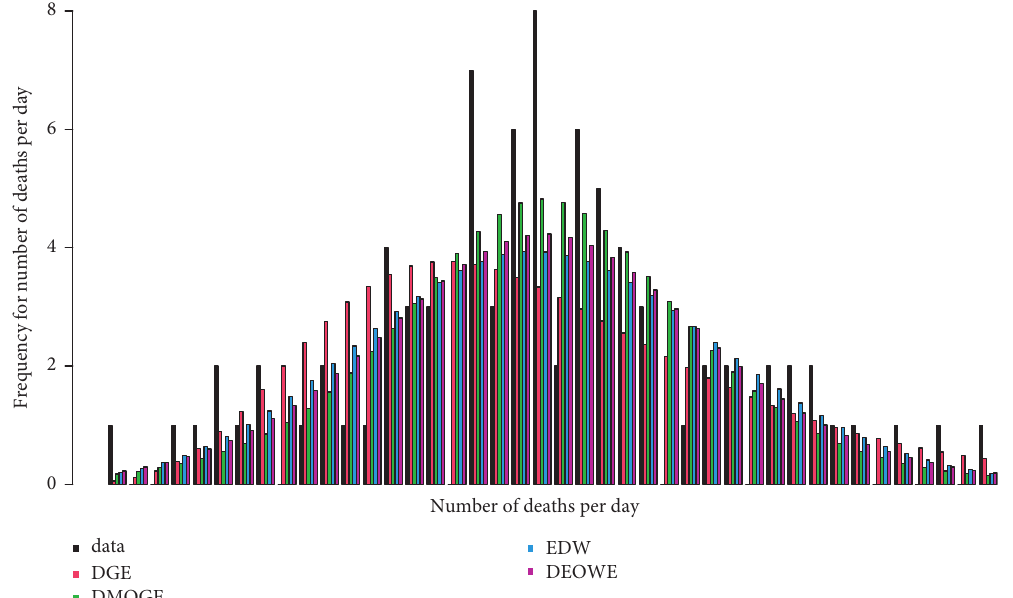
Figure 9: Graphical plots for the expected frequencies and the data using the PMF of different parameters distributions, where the x -axis represents the number of deaths per day and the y -axis represents the frequency for this number.